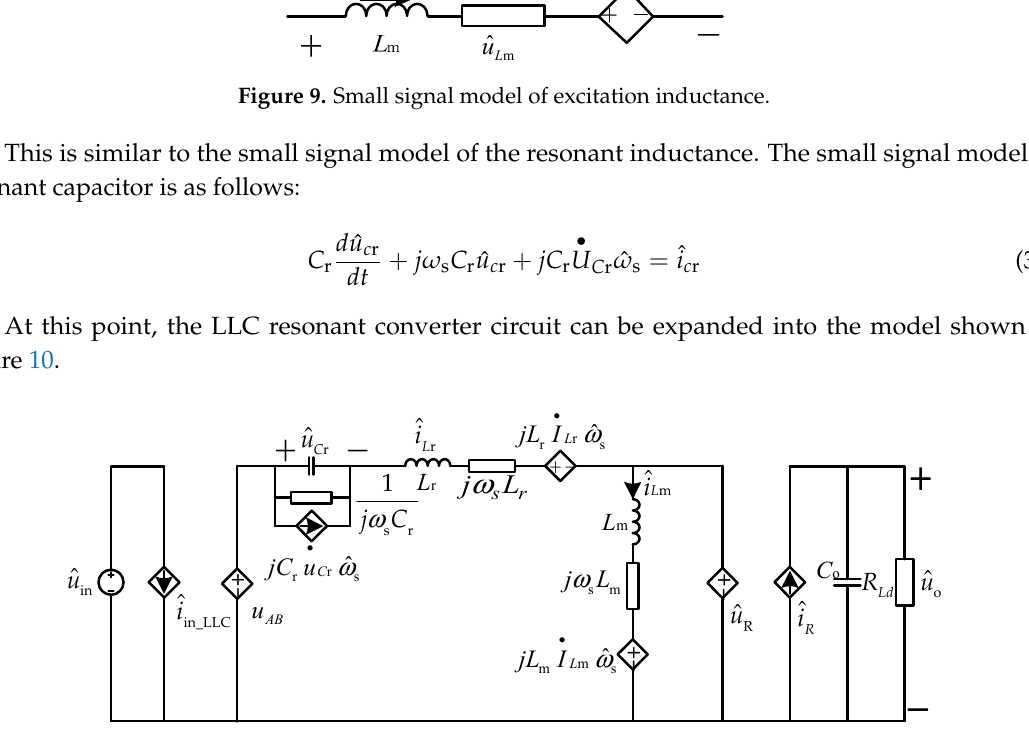
Figure 10. LLC resonant converter small signal model in real field.